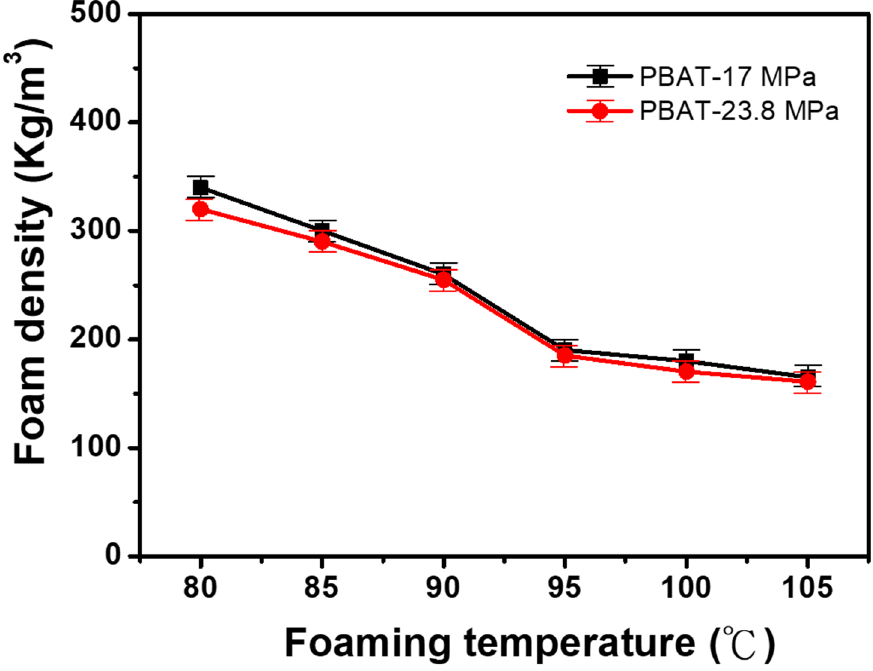
Figure 2. Dependence of PBAT foam density on six foaming temperatures and two foaming pres-